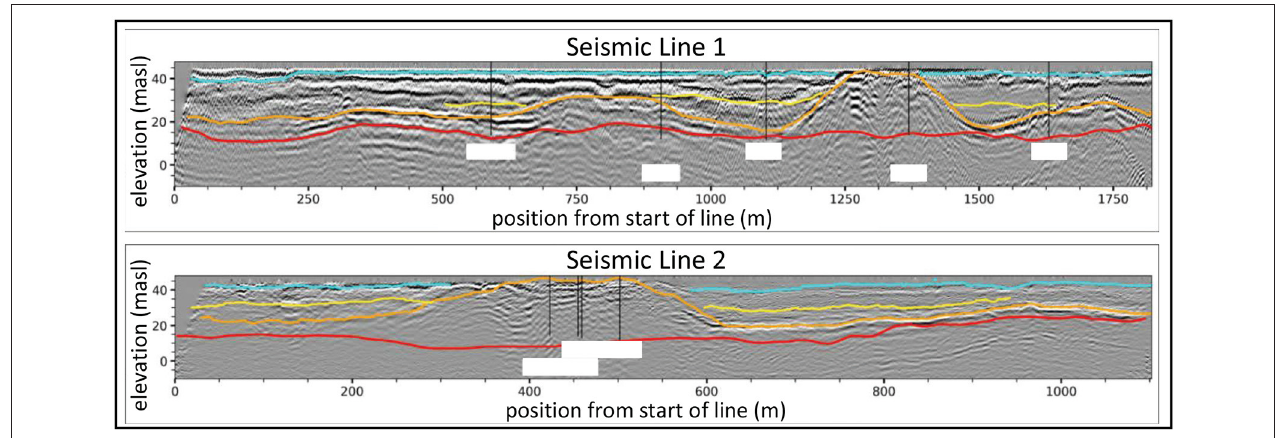
FIGURE 3 | Two seismic reflection lines with 4 seismic horizons picked, from top to bottom : S3 (cyan), S2 (yellow), S1 (orange), and S0 (red).